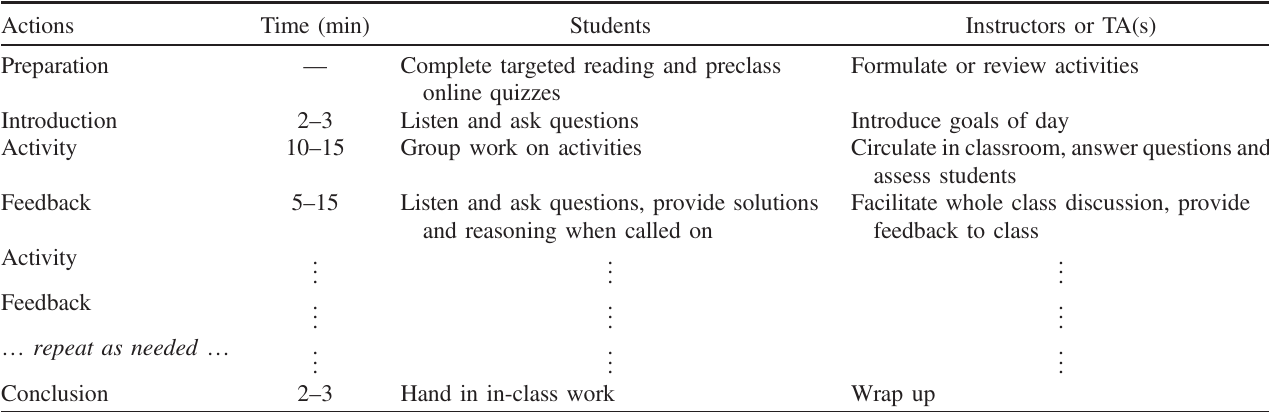
TABLE II. Progression through sequential stages of a typical class period. Each action of students and instructors is described in detail within